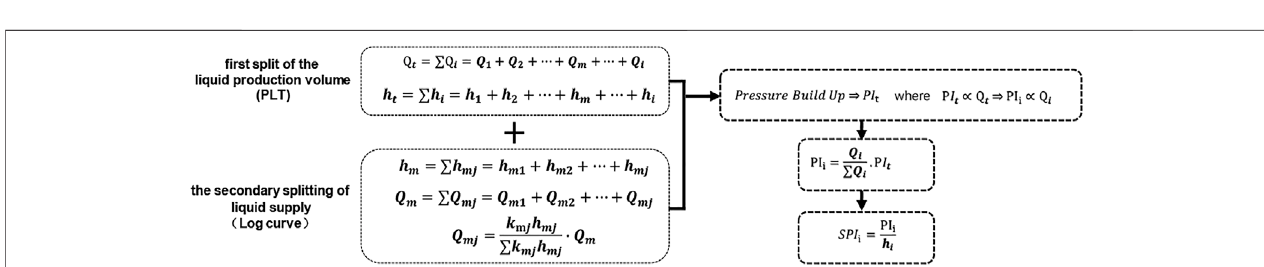
Frontiers in Energy Research |